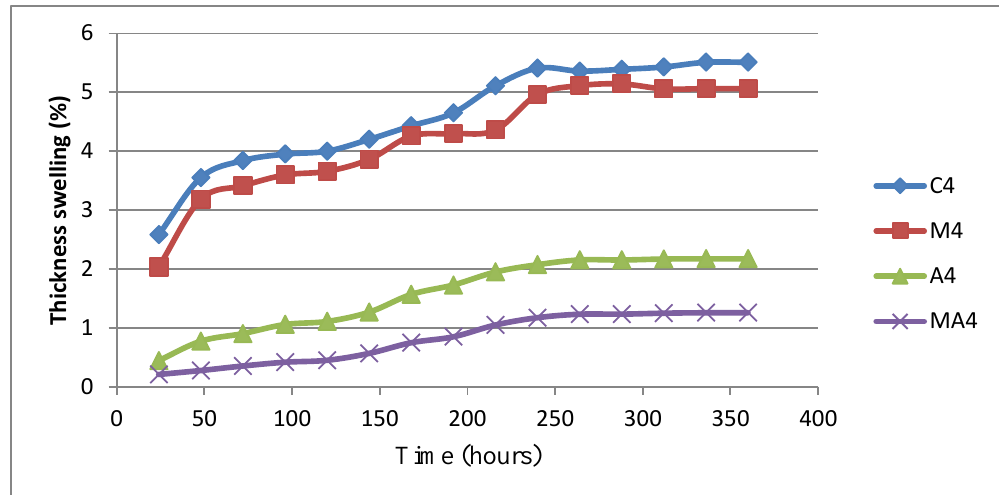
Fig. 11. Comparison of thickness swelling, among various treatments, due to moisture absorption for P4 fibre